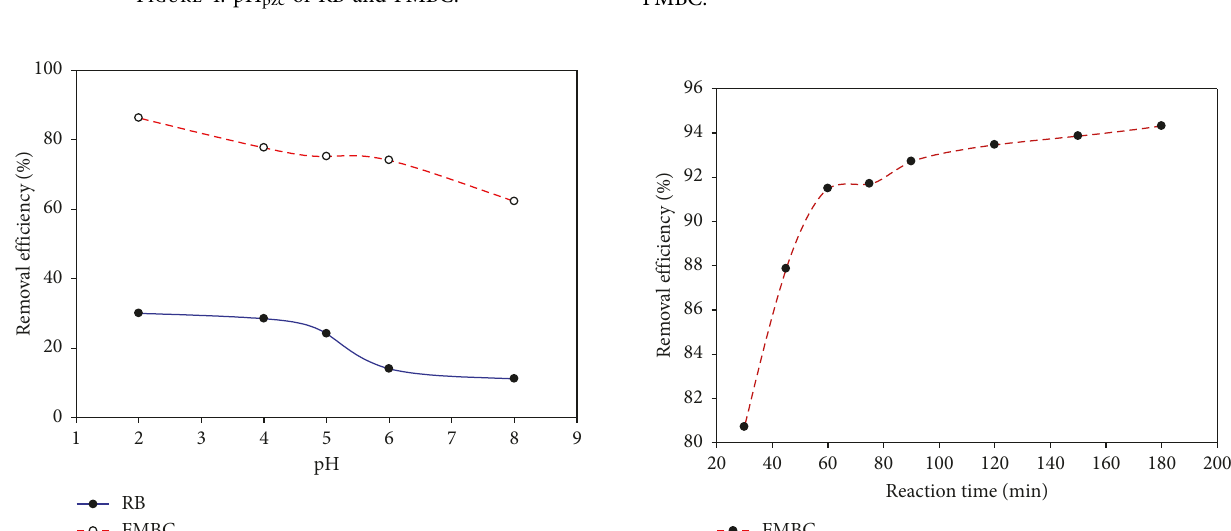
Figure 6: Effect of initial concentration for the As(V) removal on FMBC.